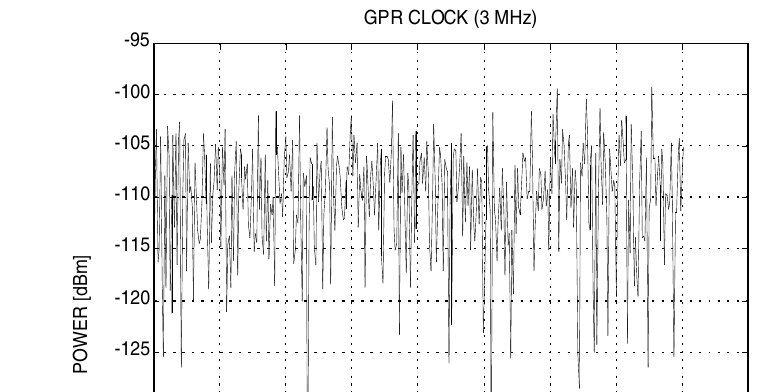
Fig. 2. Noise generated by the timing system.